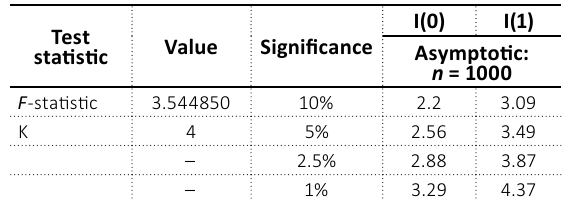
Table 1. F -bounds test